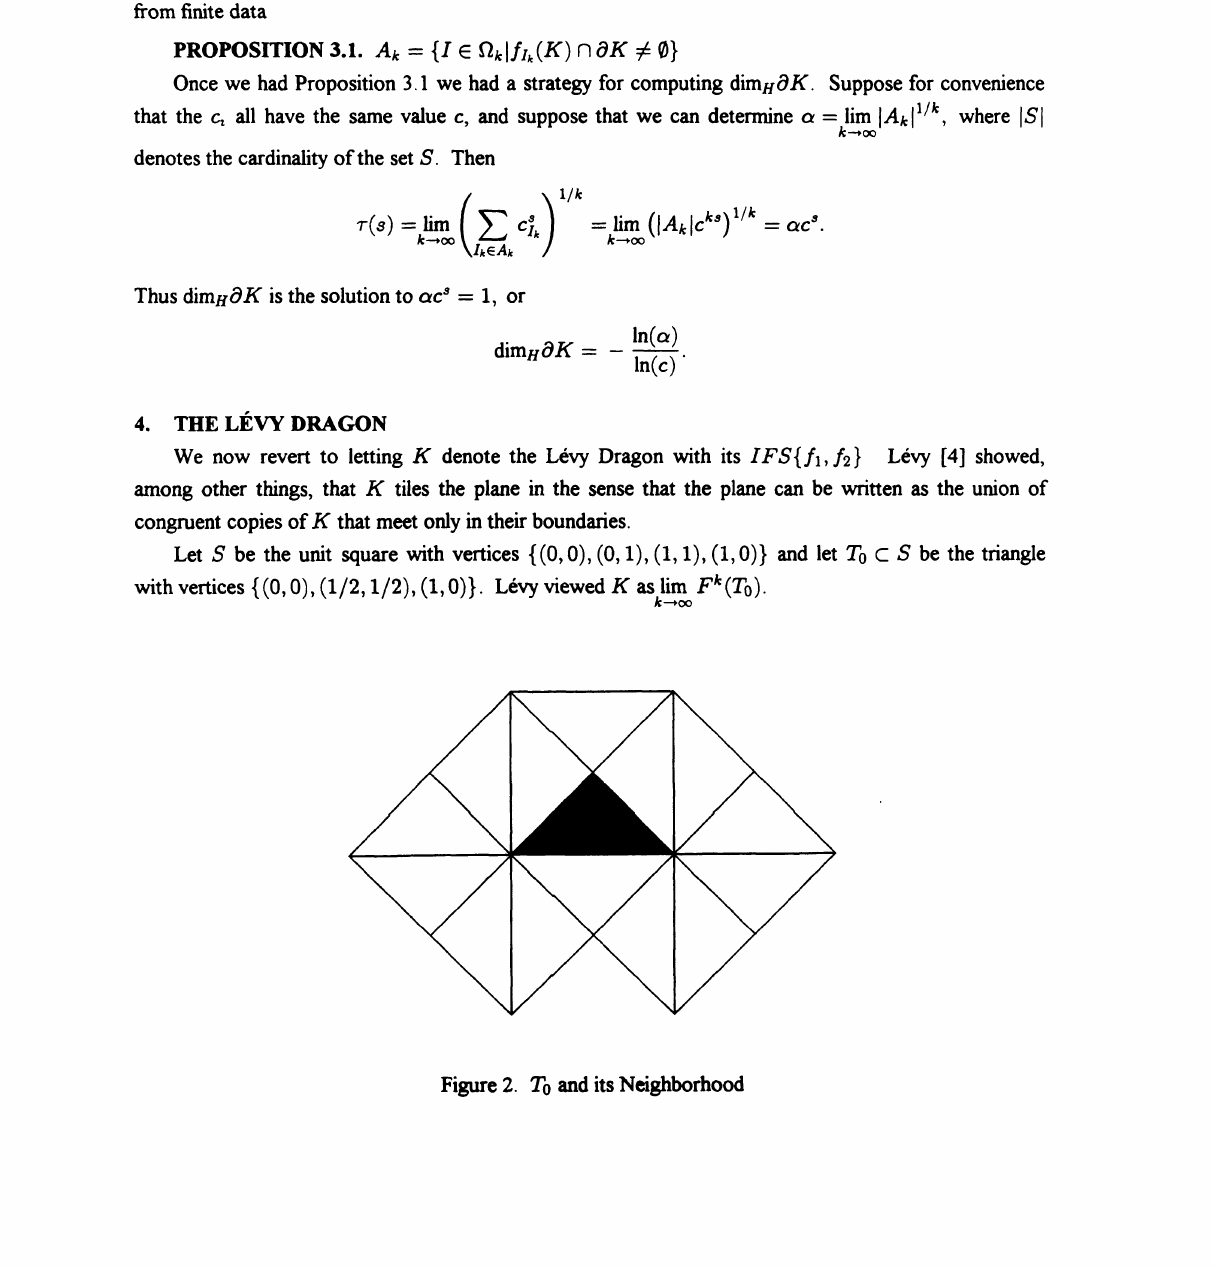
Figure 2. To and its